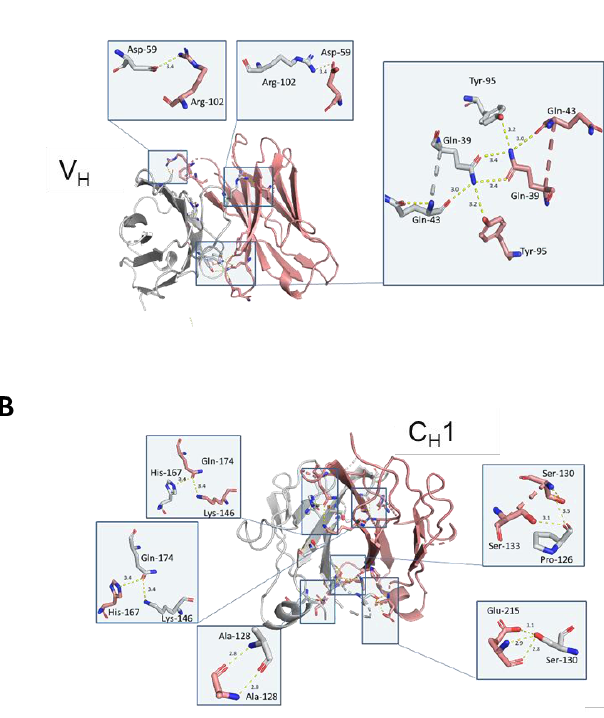
Figure 7. ( A ) Key interfacial contacts highlighted in the variable region (V H ). ( B ) Key interfacial contacts highlighted in the constant region (C H 1). Fd chains A and B are colored salmon and gray.